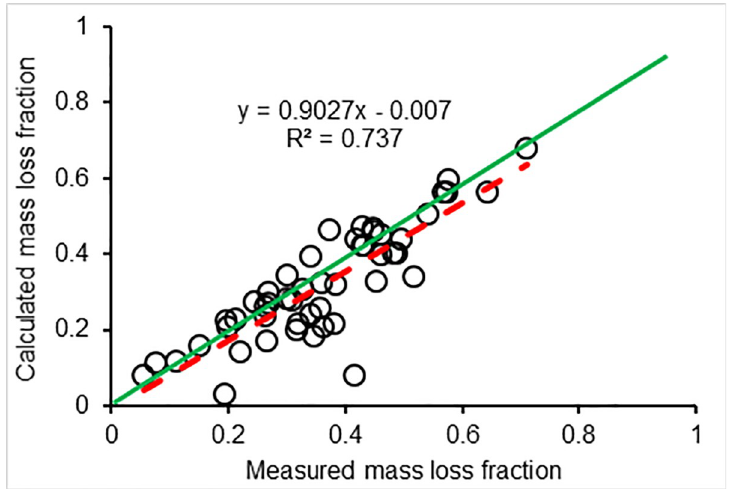
Fig 6. Measured vs calculated wood mass loss based on the disks collected from FACE logs in the nine EFs; red dashed line, regressed relationship between the measured mass loss and calculated loss; green line, 1:1.